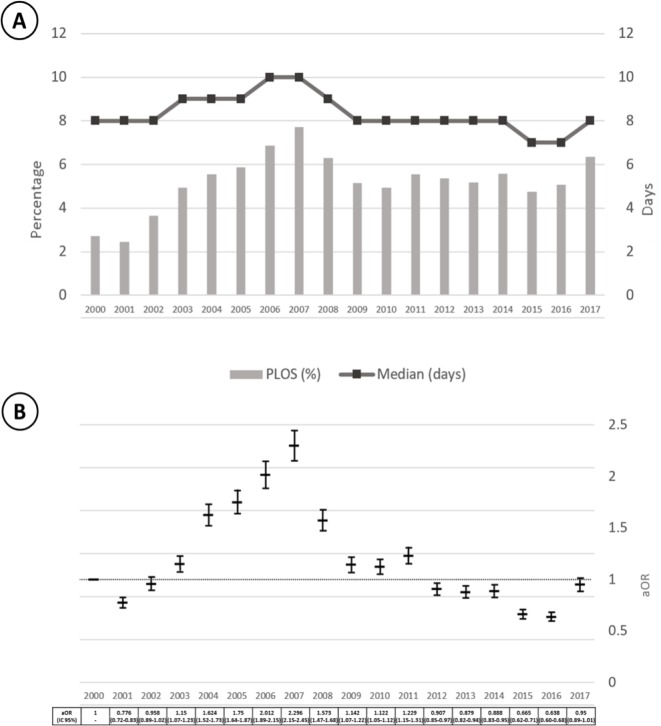
Annual frequency of hospitalizations classified as prolonged length-of-stay (PLOS) from 2000–2017.(A) The vertical, gray bars represent the annual percentage of hospitalization events classified as PLOS. The percentage increased from 2.4% in 2000 to 7.6% in 2007, then declined slightly in the ensuing years and remained stable during 2009–2016 with a later peak in 2017. The black, dotted line, summarizes the annual median length-of-stay (LOS) in days across time, during the study period. The median LOS for all hospitalization events was 8 days in 2000, peaked at 10 days in 2006 and 2007 and then declined to 8 days afterwards and up to 2015, when it declined again by one day (B). The black, vertical, boxplots illustrate the annual adjusted odds ratios (aORs) for prolonged stay of hospitalization (PLOS) using 2000 as the year of reference. We used multinomial logistic regression models to control for age, gender, type of admission, recent hospital discharge, weekday/weekend admission, additional diagnoses, place of residence and socioeconomic status, using inverse probability weights based on diagnosis of admission. The adjusted risk of PLOS increased between 2000 and 2007, then substantially and continuously decrease afterwards despite a sustained percentage of PLOS episodes after 2008.